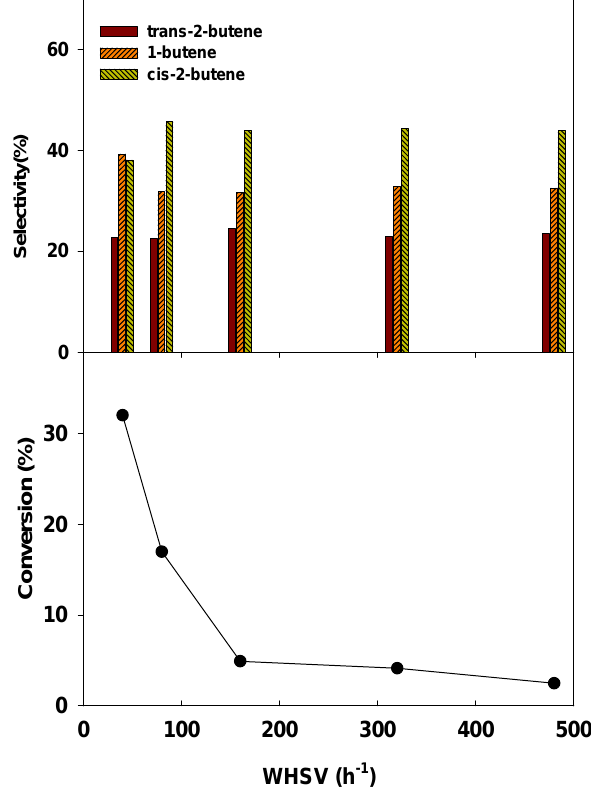
Figure 7. Effect of space velocity on conversion and selectivity in 2-butanol